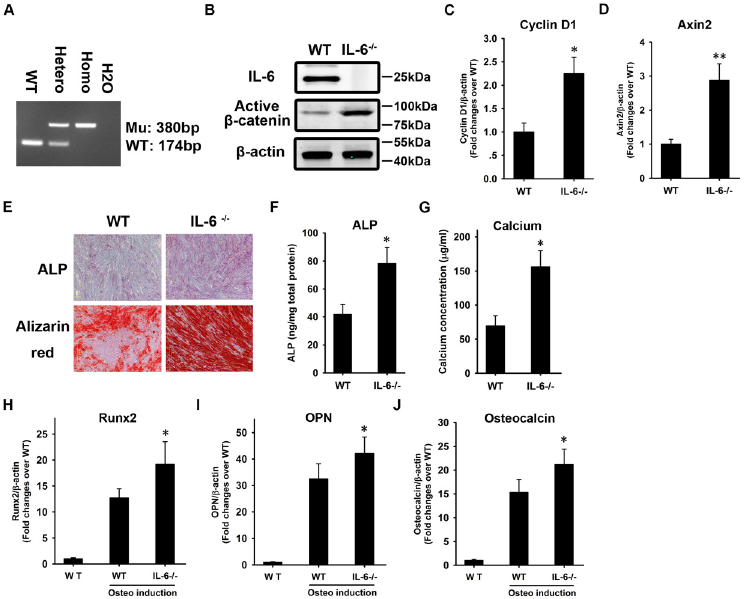
Fig 7. Knockout of IL-6 enhances the osteogenesis of BMSCs. IL-6 -/- BMSCs were isolated from the vertebral body of an IL-6 -/- mouse (A) . A wild-type (WT) mouse was used as a control. Total protein was harvested, and western blotting was carried out using antibodies against IL-6 and active β -catenin (B) . Total RNA was harvested for quantitative RT-PCR using primers for cyclin D1 (C) and Axin2 (D). The results are expressed as fold-changes relative to BMSCs from the wild-type mouse. WT and IL-6 -/- BMSCs were induced to undergo osteogenesis. Alkaline phosphatase (ALP) and Alizarin Red staining were performed at weeks 1 and 3, respectively (E) . The quantification of ALP (F) and measurement of calcium concentration (G) were performed. At week 2, total RNA was extracted and subjected to quantitative RT-PCR analysis using primers for Runx2 (H) , OPN (I), and OC (J) . β -actin was used as a control. The results are expressed as fold-changes relative to WT BMSCs without induction. The data are shown as the mean ± SD. * : p < 0.05 and ** : p < 0.01, IL- 6 -/- vs .